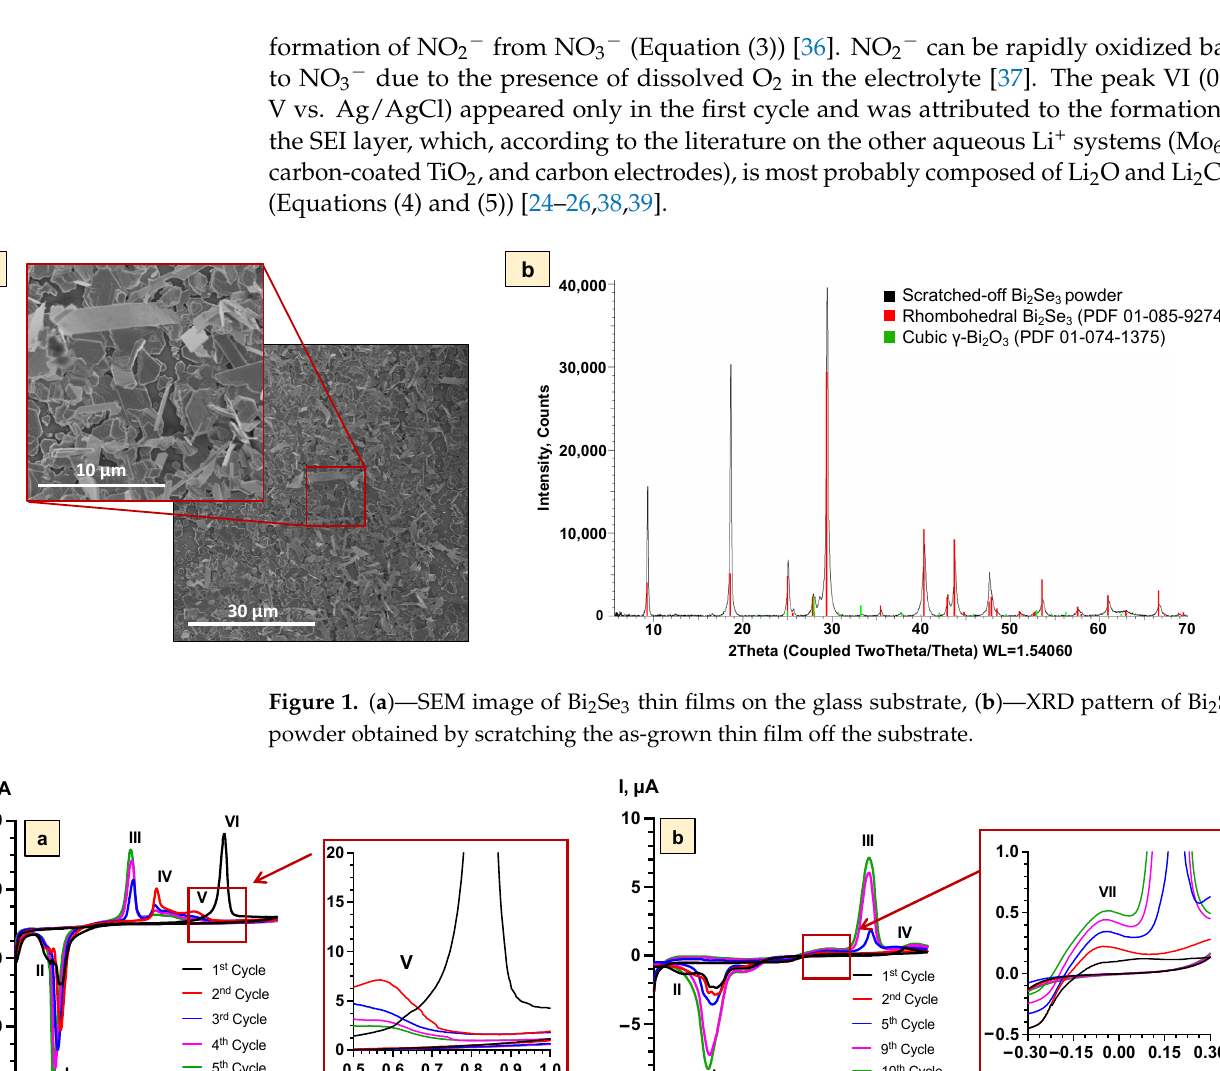
formation of NO 2 − from NO 3 − (Equation (3)) [36]. NO 2 − can be rapidly oxidized back to NO 3 − due to the presence of dissolved O 2 in the electrolyte [37]. The peak VI (0.84